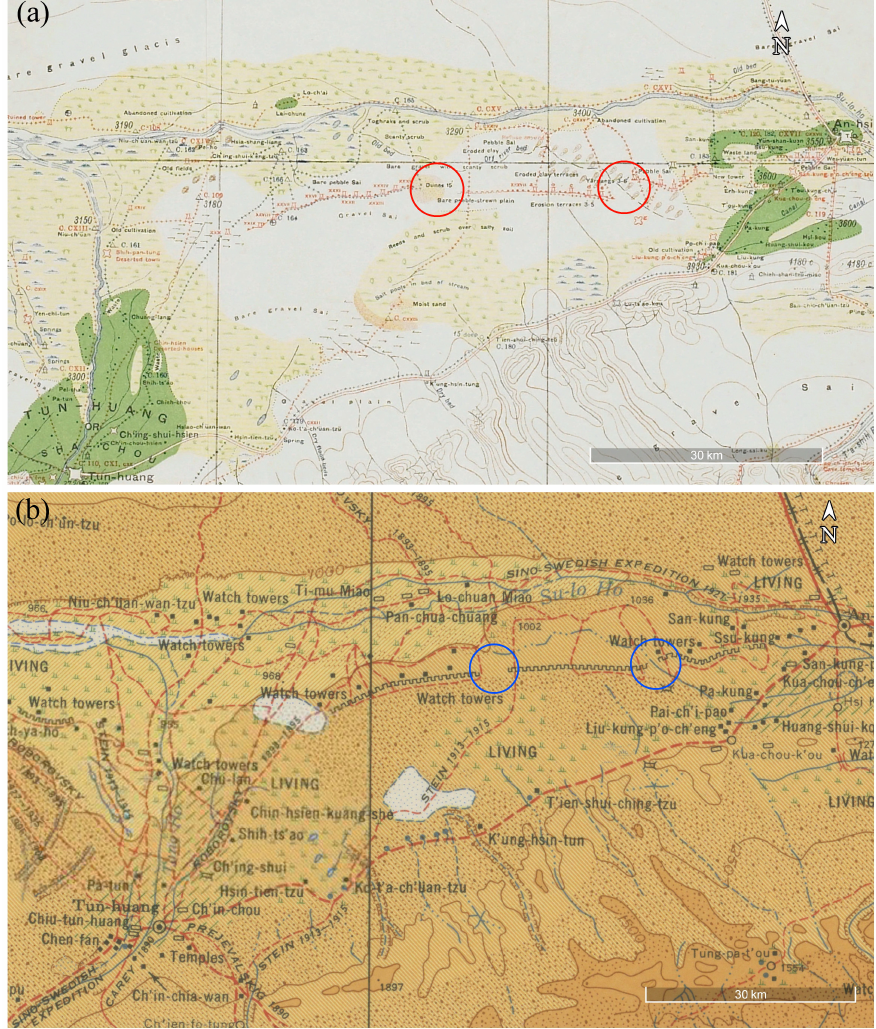
Figure 2. The locations of the Dunhuang Section of the GH and ancient Dunhuang in Stein’s [21] ( a ) and Hedin’s [22] ( b ) archaeological maps, which can be downloaded from http: // dsr.nii.ac.jp / . The red and blue circles indicated that the absence of the